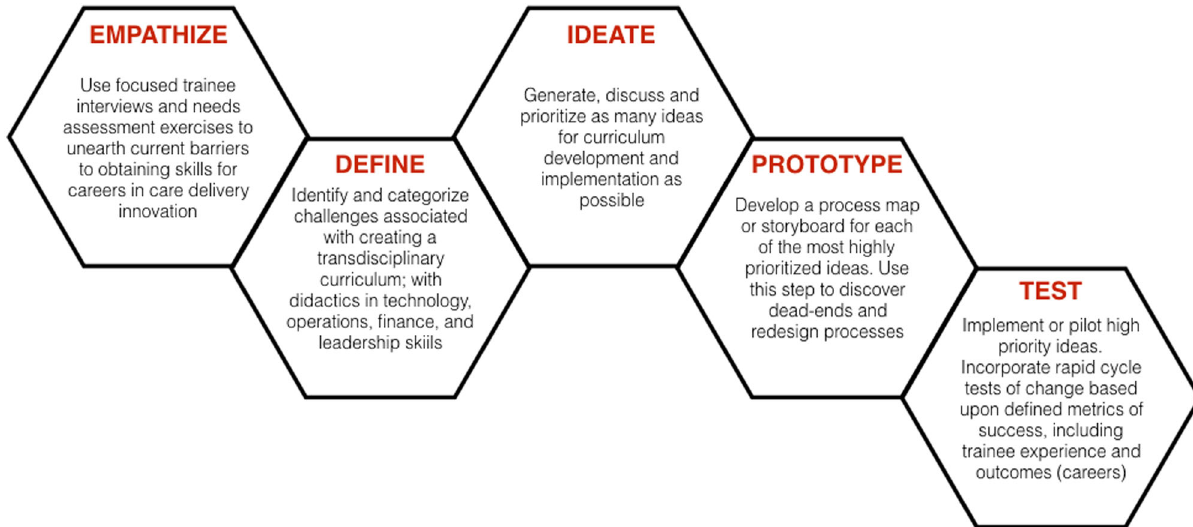
Fig. 1 Application of human-centered design principles to implementation of an innovation training pathway. Source : Stanford d. School Design Thinking